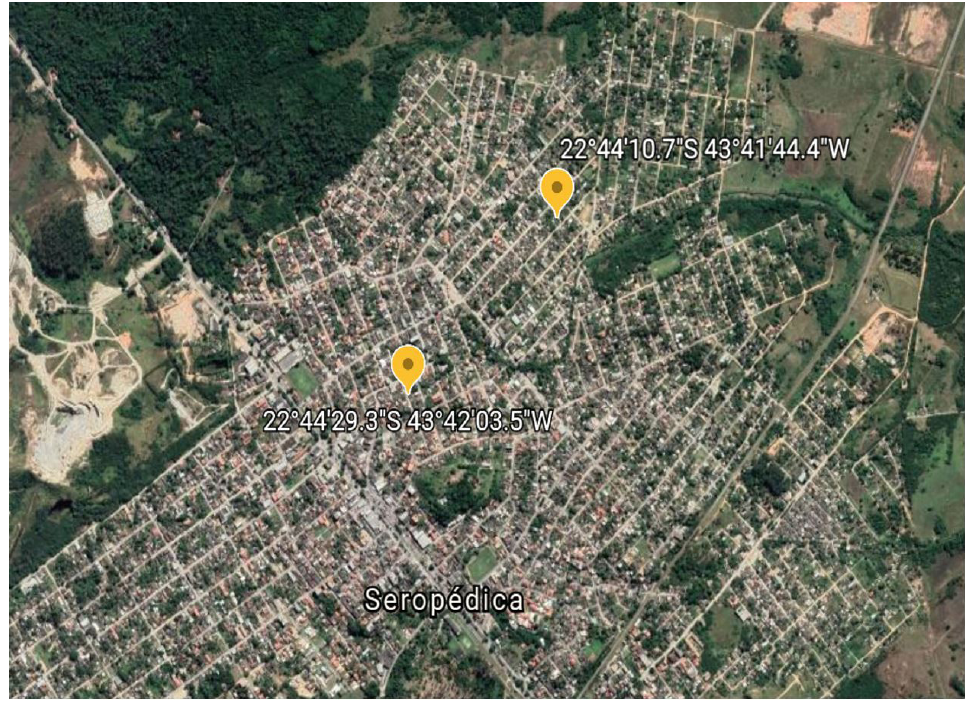
Figure 1. Map showing the home location of autochthonous cases reported in Seropédica, RJ,